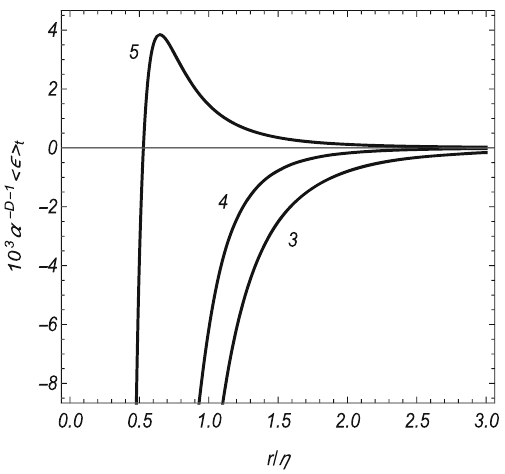
Fig. 2 Topological contributions in the VEV of the energy density in spatial dimensions D = 3 , 4 , 5 (the numbers near the curves ) for q = 2 .